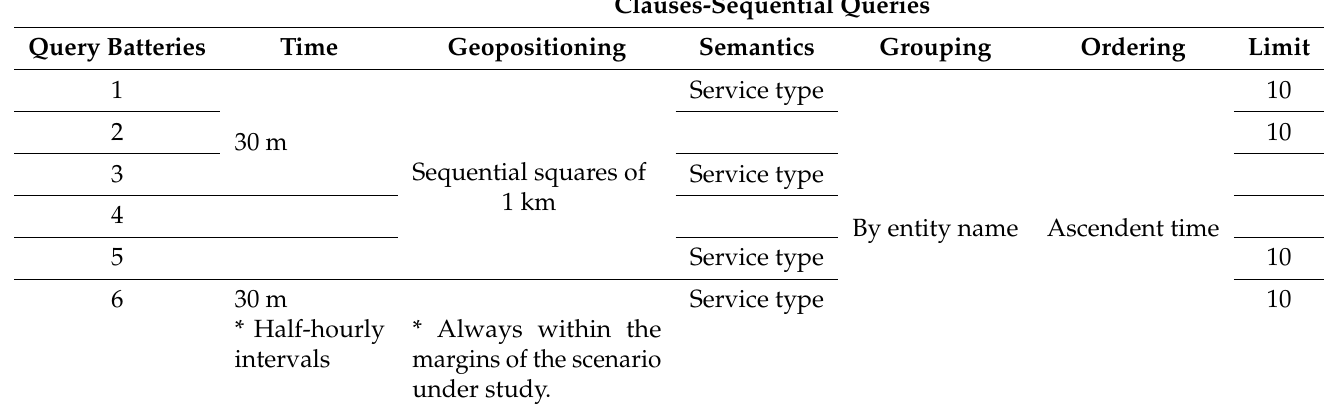
Table 6. Sequential query